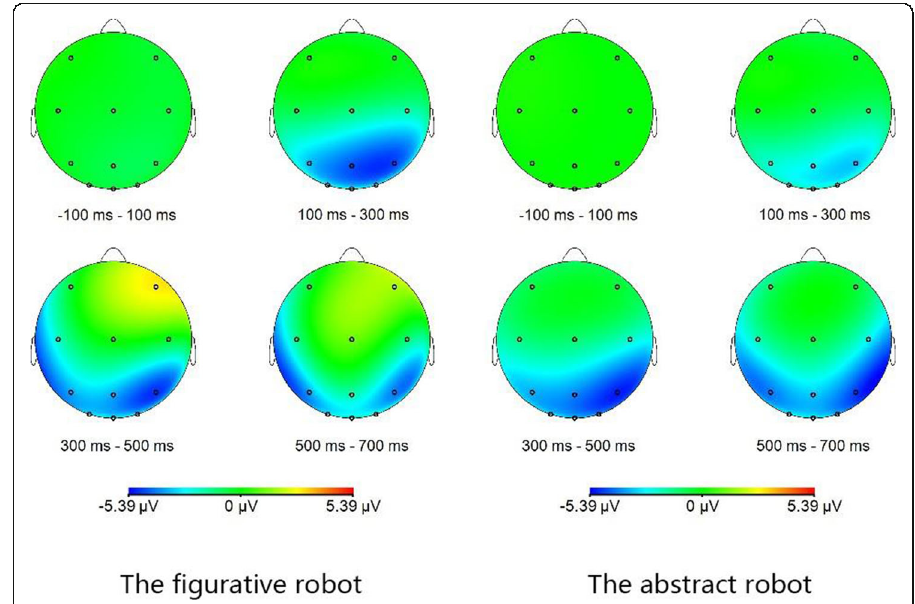
Fig. 3 Electroencephalogram topographic map of two types of